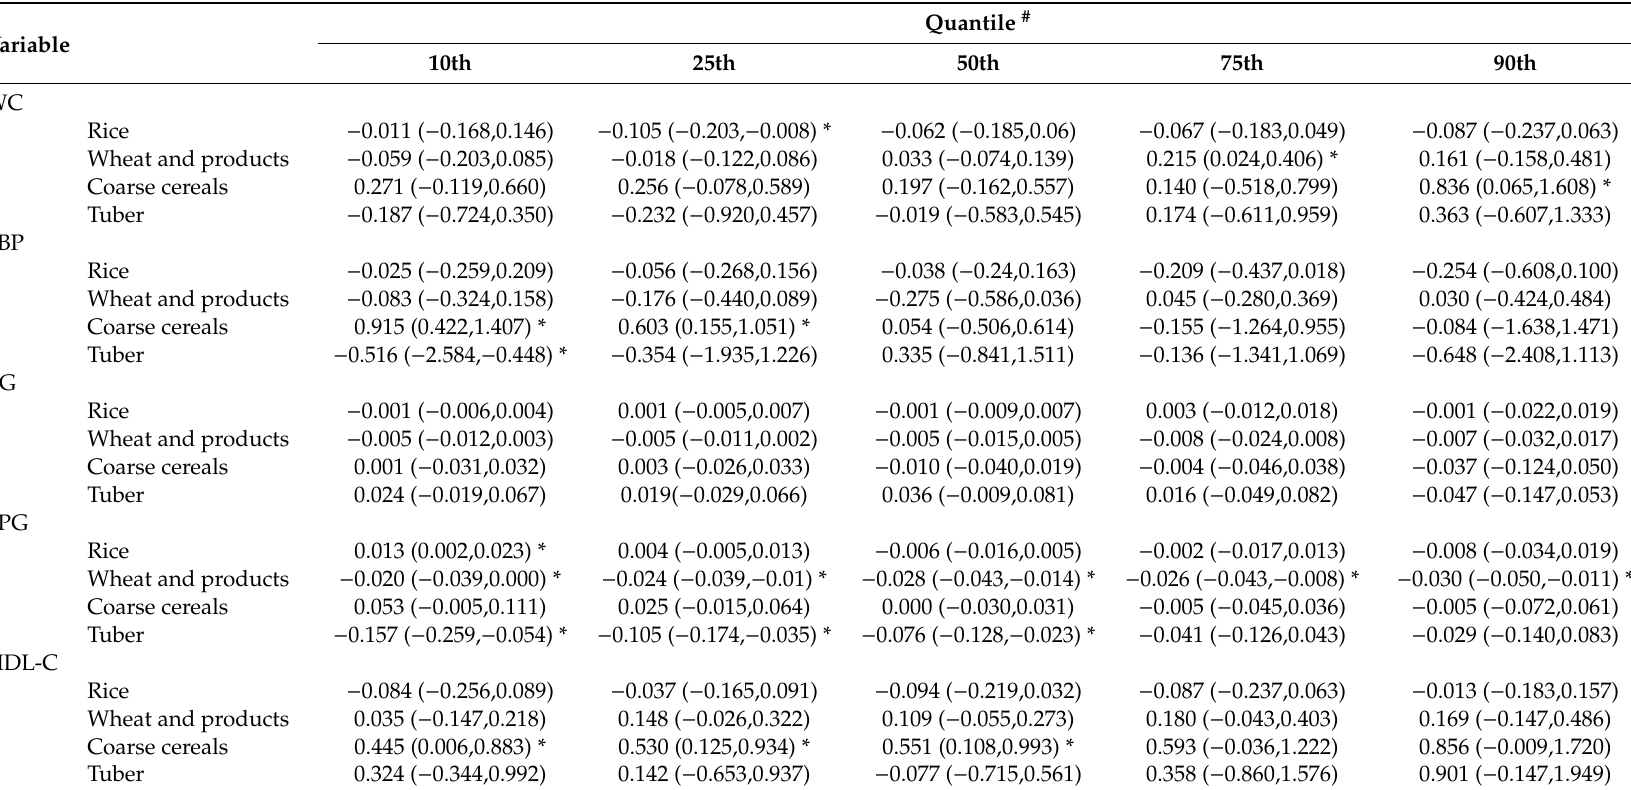
Table 7. Coe ffi cient estimates from a quantile regression on individual components of MetS among southern China by cereals consumption.